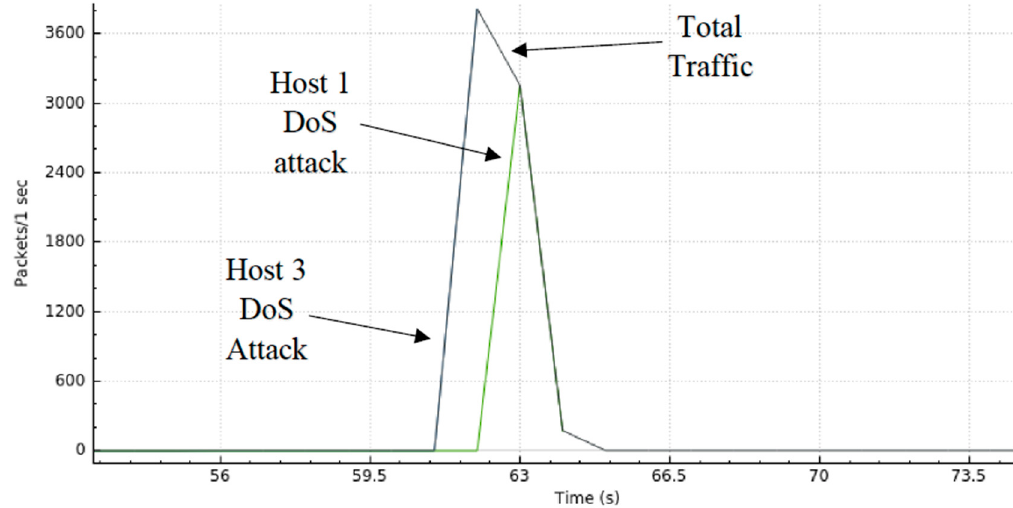
Figure 12. Scenario I—DDoS Attack and Mitigation.